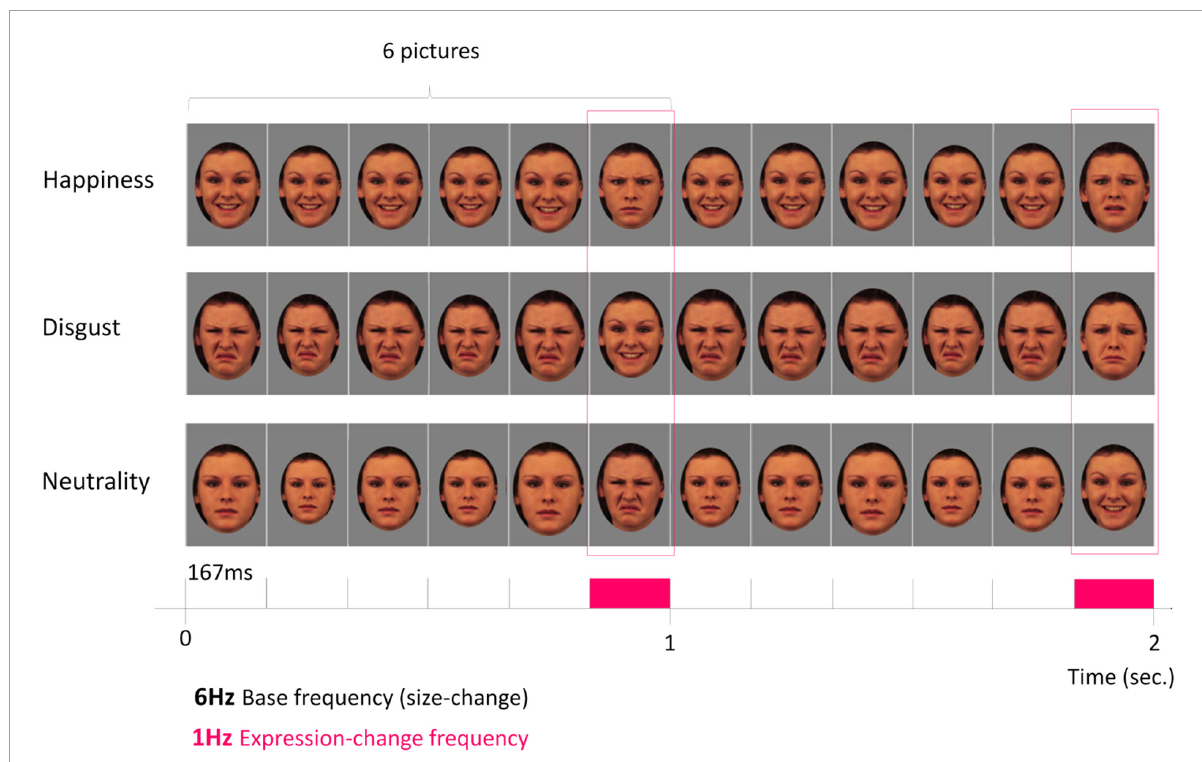
FIGURE1 Fast periodic visual stimulation in electroencephalography (FPVS-EEG) to isolate a neural marker of rapid discrimination of facial expression. Among the five basic emotional facial expressions used (disgust, happiness, anger, fear, sadness) and neutrality, the discrimination of three target expressions was tested (disgust, happiness and neutrality). A 2-s sequence of fast periodic stimulation is depicted with images from one individual face. From top to bottom: happy, disgust, and neutral facial expressions are respectively used in dedicated sequences and periodically displayed at the 6-Hz base rate (i.e., six pictures per second; 1 cycle ≈ 167 ms) without inter-stimulus interval, and the five other expressions are randomly displayed at the 1-Hz expression-change frequency (every 6th cycle = 1 s between each expression-change). Images were presented through ± 15% randomized size variation at each cycle. This design thus isolates two dissociated responses at two different frequencies: a general visual response (6 Hz) to the rapid train of one individual face varying in size and an expression-change response (1 Hz) reflecting rapid (i.e., single-glance) discrimination of all inserted expressions from the target expression presented at the base rate. Source: KDEF database (models coded 07F, 09F, 14F, and 20F) (Lundqvist et al.,